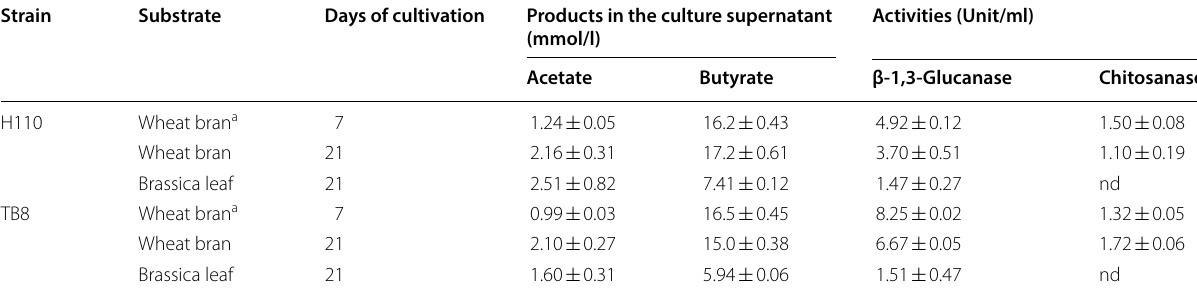
Table 4 Products and enzymatic activities in the culture supernatants of strains H110 and TB8 grown with wheat bran and Brassica leaves in the PY broth